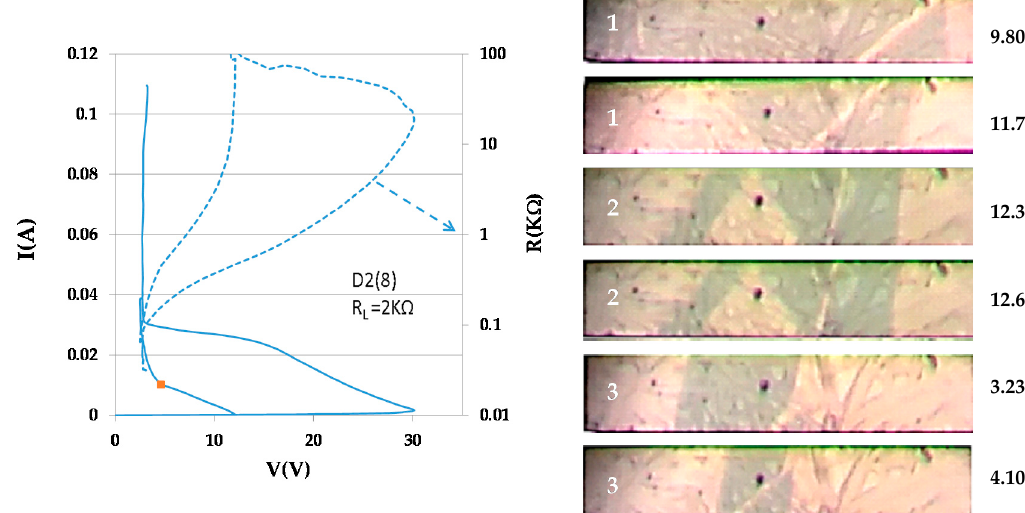
Figure 5. The first of three almost identical I–V characteristics of sample D2(8). The M–I patterns for the same current (see pairs of images at the right) are very different. A narrow semiconducting domain slides with very low velocity.